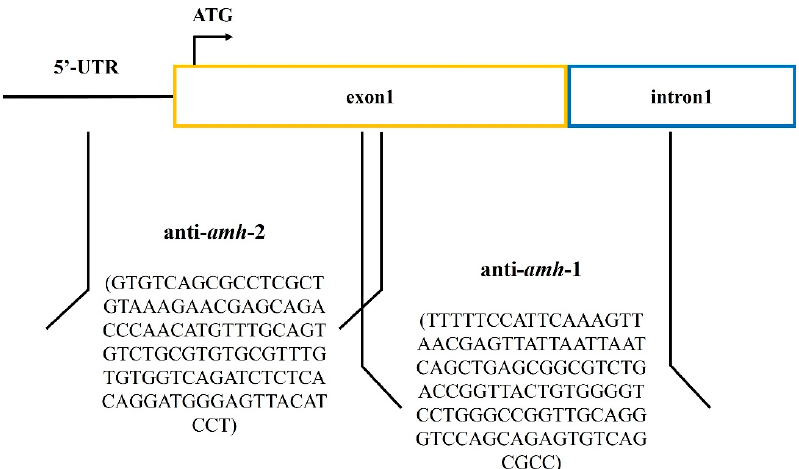
Figure 1. Design and action site of two amh antisense RNA sequences. Interference sites of the two antisense RNAs (anti- amh -1 and anti- amh -2).